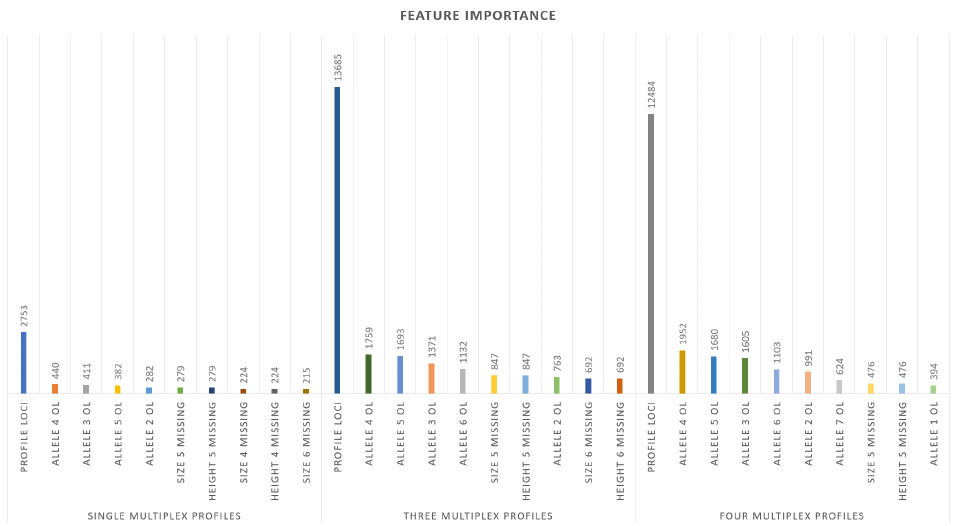
Figure 20. Feature importance: single, three, and four multiplex